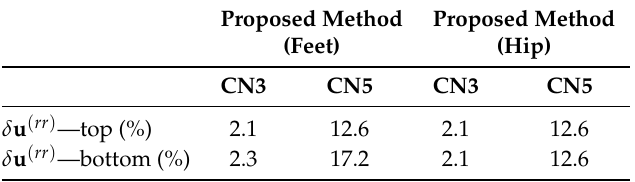
Table 7. The calibration results on EPFL-Terrace (CN3) and Camera Network 5 (CN5). For EPFL-Terrace (CN3) and Camera Network 5 (CN5), we apply the proposed method on the first half of the video to obtain the extrinsic parameters. δ r ( w ) , δ u ( p ) , δ u ( r ) are not available for these sequences. Thus, the δ u ( rr ) denotes relative reprojection error is the only one available for these